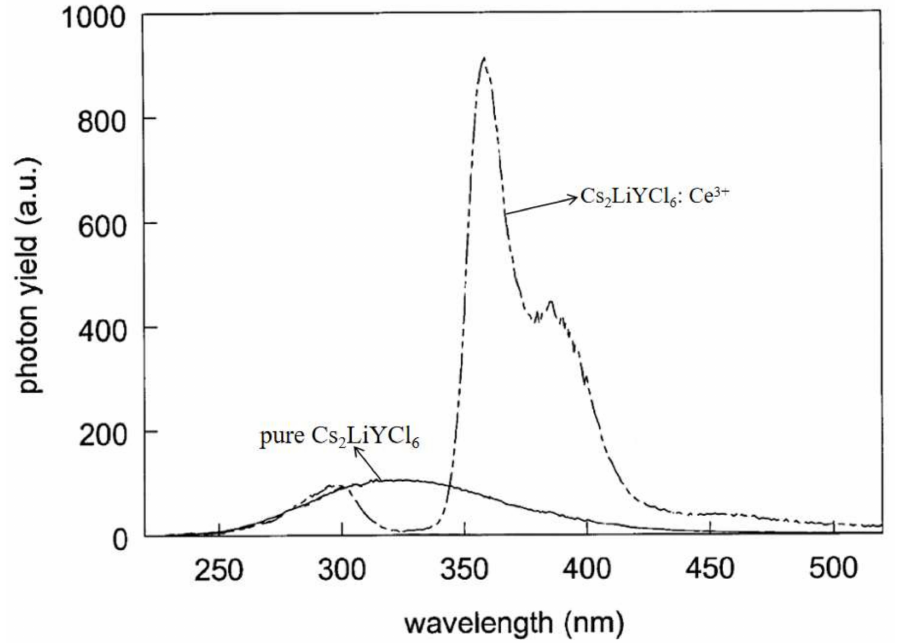
Figure 5. X-ray-excited emission spectra of pure Cs 2 LiYCl 6 (solid line) and Cs 2 LiYCl 6 :Ce 3+ (dashed line) recorded at room temperature. The emission intensity of crystals was normalized at 300 nm. Reproduced with permission [32]. Copyright 1999, Elsevier Science